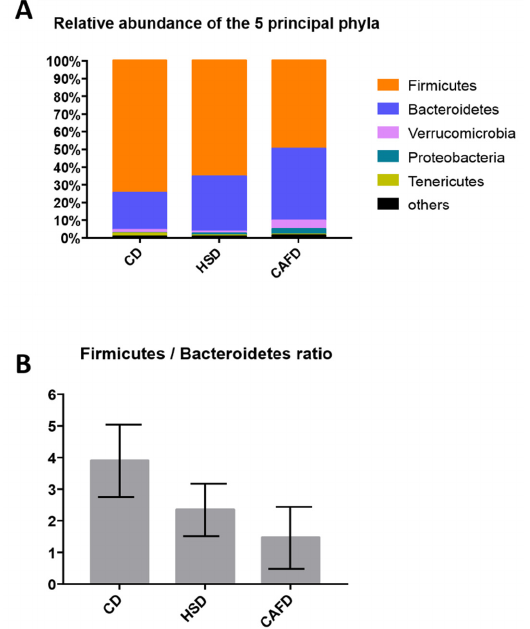
Figure 2. Graphical representation of the microbial community composition. ( A ) Major bacterial phyla in the gut microbiota of rats after 14 weeks of chow diet (CD), high-sugar (HSD) or cafeteria diet (CAFD) feeding. Bars represent the average relative abundance of each phylum in the 3 different diet groups. Each phylum is represented by a different color (n = 5 to 9 rats per group). ( B ) Firmicutes to Bacteroidetes ratio among groups. Values are expressed as mean ± SD (n = 5 to 9 rats per group).